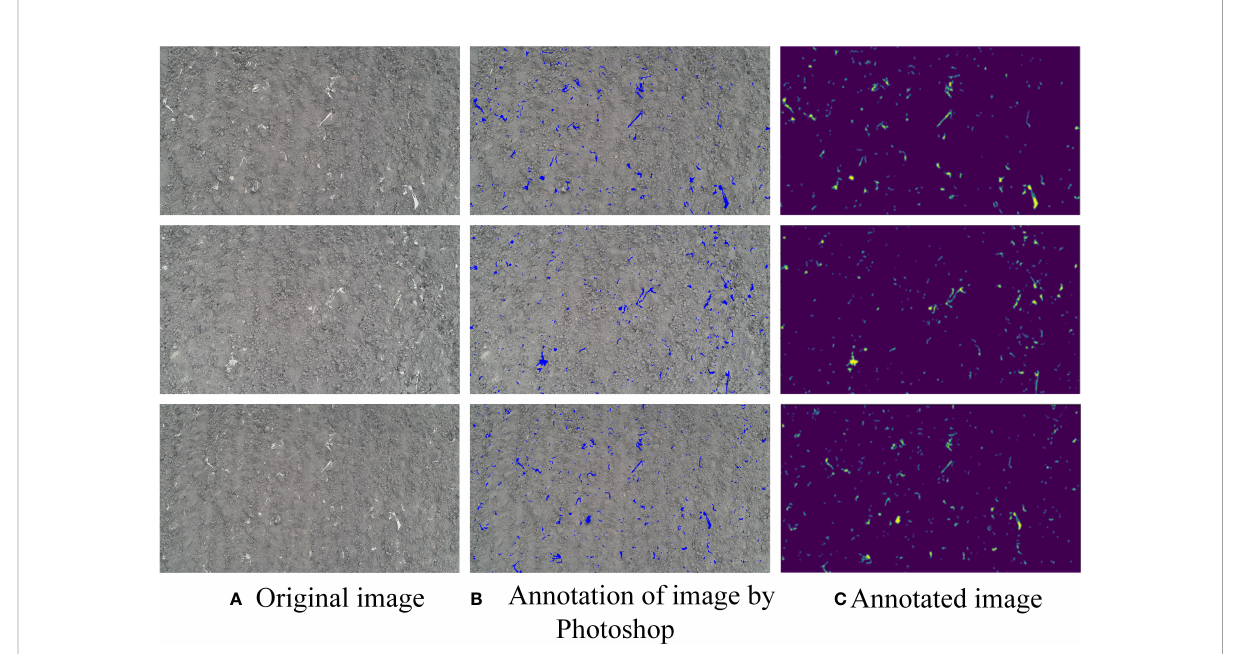
FIGURE 3 Schematic diagram of data annotation. (A) Original image; (B) Annotation of image by Photoshop; (C) Annotated